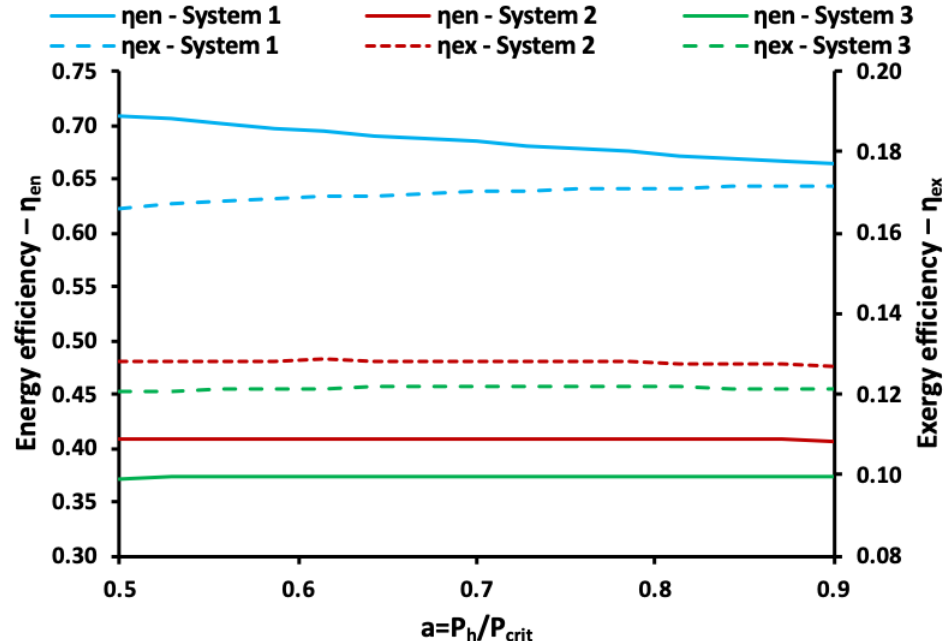
Figure 7. Energy and exergy efficiency for the three systems with different values of the pressure ratio parameter.